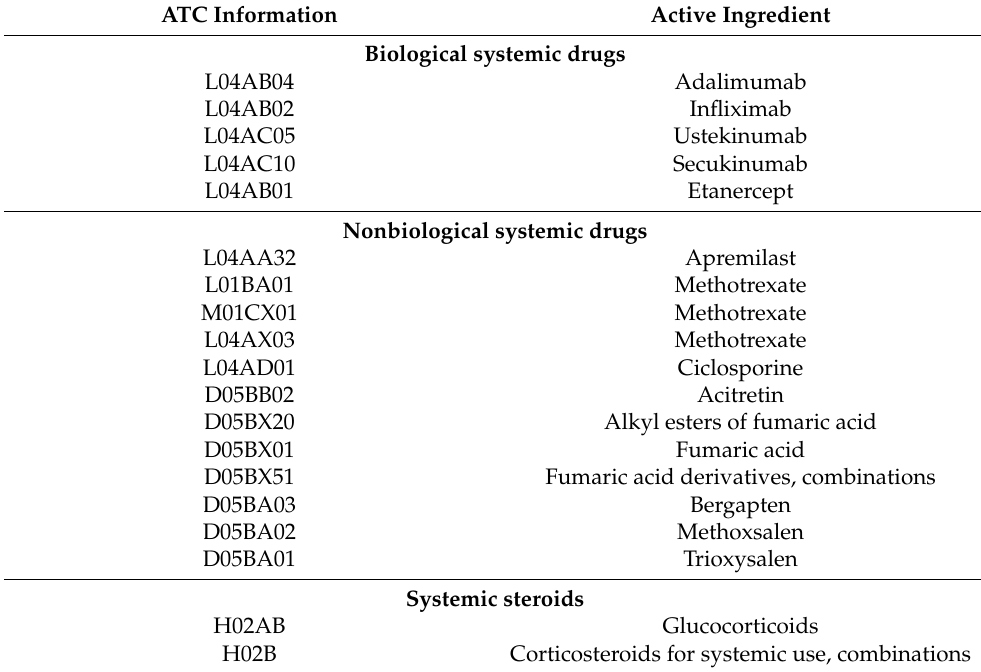
Table 3. Psoriasis-relevant systemic therapeutics (approval before 2015) [21].